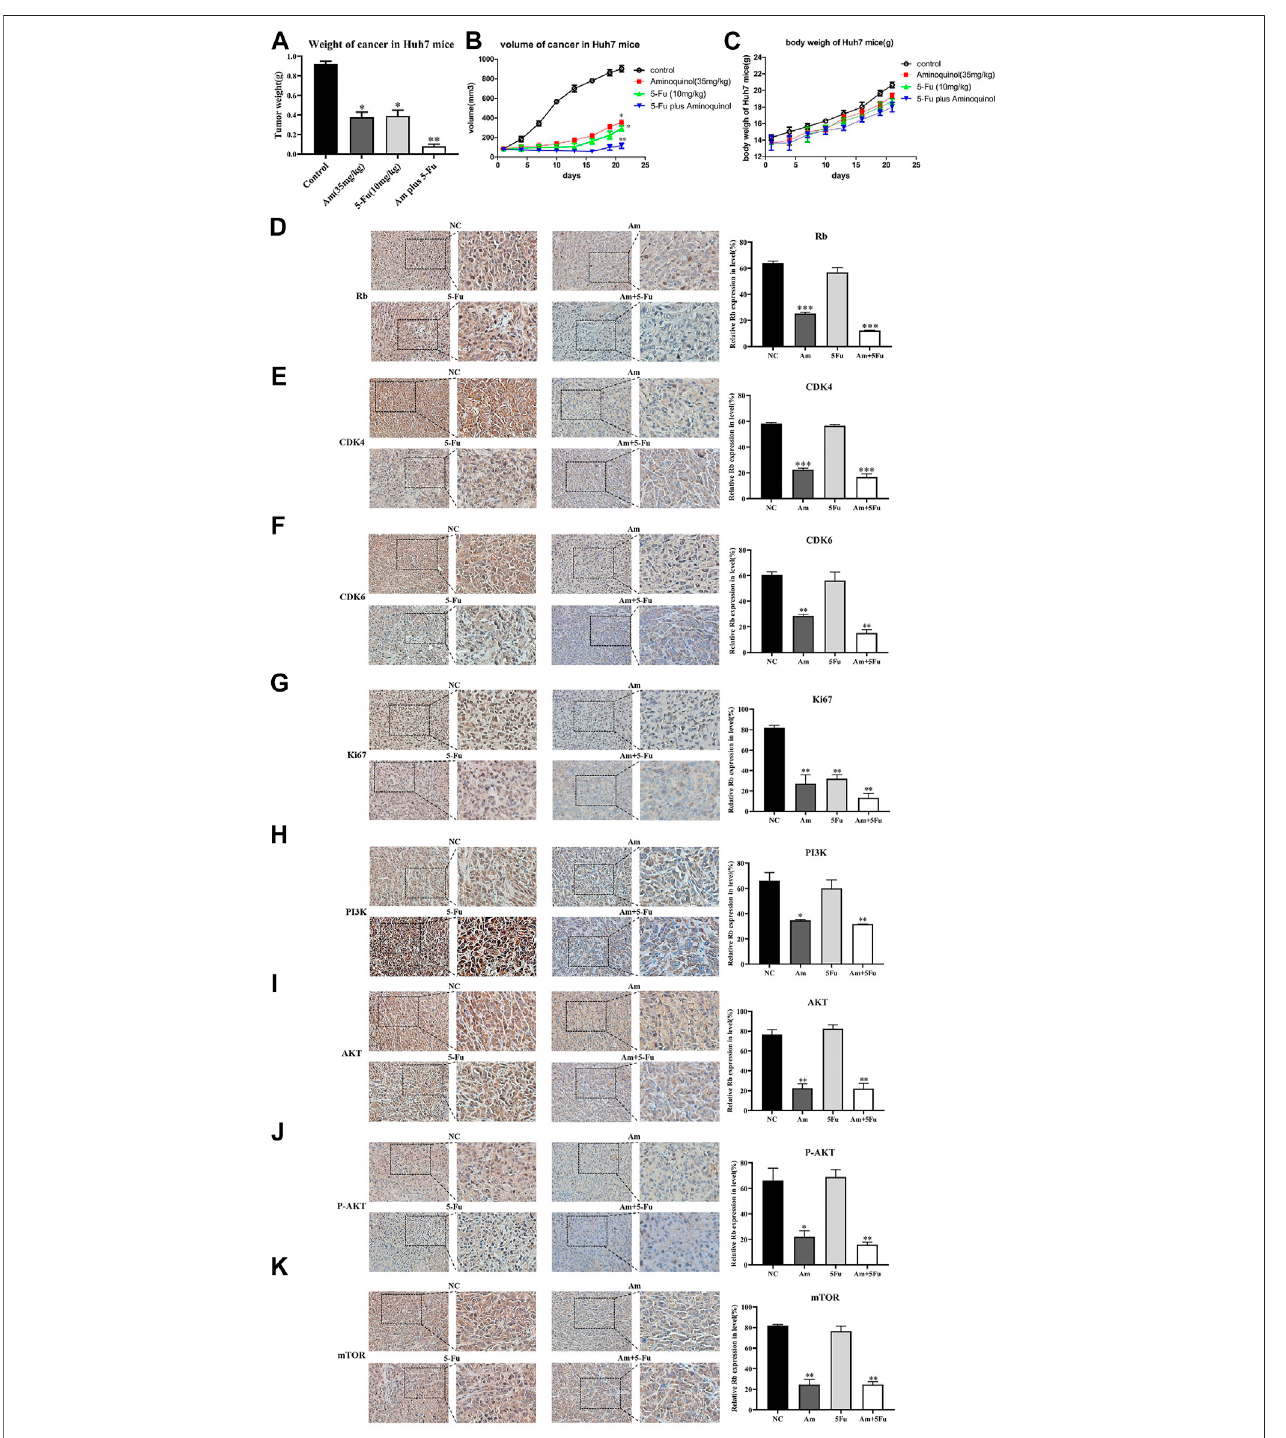
FIGURE 7 | Aminoquinol treatment inhibited tumor growth in vivo in BALB/C nude mice xenografted with Huh7 cells. BALB/C nude mice xenografted with Huh7 cellsweretreatedwithaminoquinol(35 mg/kg),5-Fu(10 mg/kg),aminoquinol(35 mg/kg)plus5-Fu (10 mg/kg)andPBSfor21 daysdailybyintraperitonealinjection (A) Tumor weight at 21 days after treatment (B) Tumor volumes during the experiment (C) The body weight of the mice during the experiment (D – K) The representative pictures and quanti fi ed data of immunohistochemistry staining of the xenografted tumor tissues for the expressions of (D) Rb, (E) CDK4, (F) CDK6, (G) ki67, (H) PI3K, (I) AKT, (J) P-AKT, and (K) mTOR. Data are expressed as the mean ± SD. * p < 0.05, ** p < 0.01, *** p < 0.001, signi fi cantly different from the control PBS treatment group.